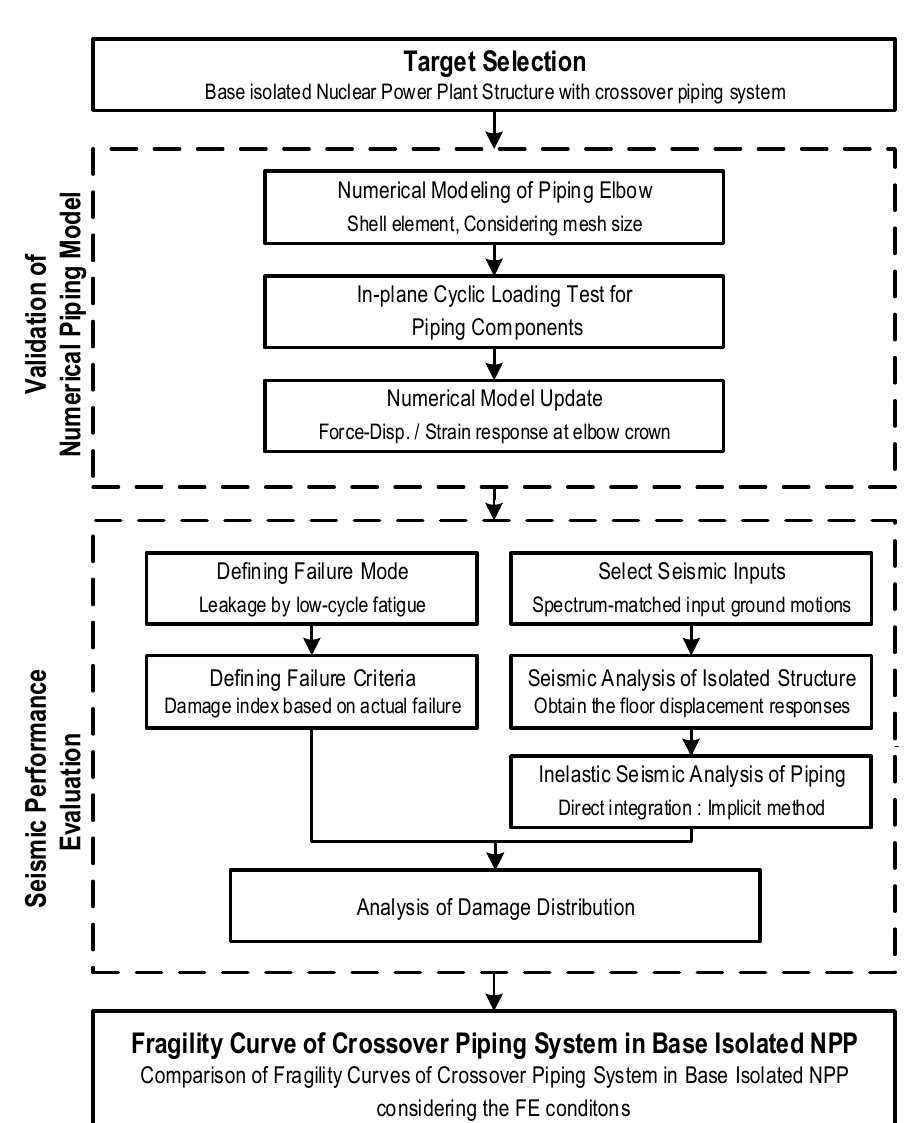
Figure 14. Procedure for calculating the seismic fragility curve of a piping system. The seismic fragility curve of the piping was checked by varying the five input earth- quakes and PGA levels (1 g, 2 g, and 3 g). The damage index was 35.25, which was calculated in Section 2. The seismic fragility curve was represented by a lognormal distribution, which confirmed a difference between the results of convergence “condition A” and “condition B”, as shown in Figure 15. Therefore, when deriving the seismic performance of piping through numerical analysis, differences occur in the results depending on the convergence conditions. The median value of the seismic fragility curve under convergence “condition A” and “condition B” was 2.8 g and 2.4 g, respectively, showing a difference of 0.4 g. Therefore, in this study, the seismic performance of the pipe was overestimated when the iteration is small for convergence.